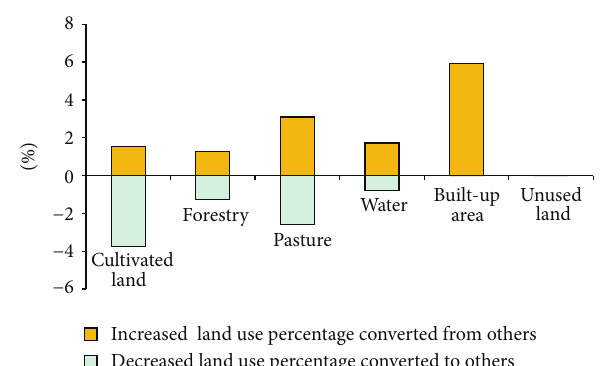
Figure 3: Changes of percentage of major land use types in Yunnan province during